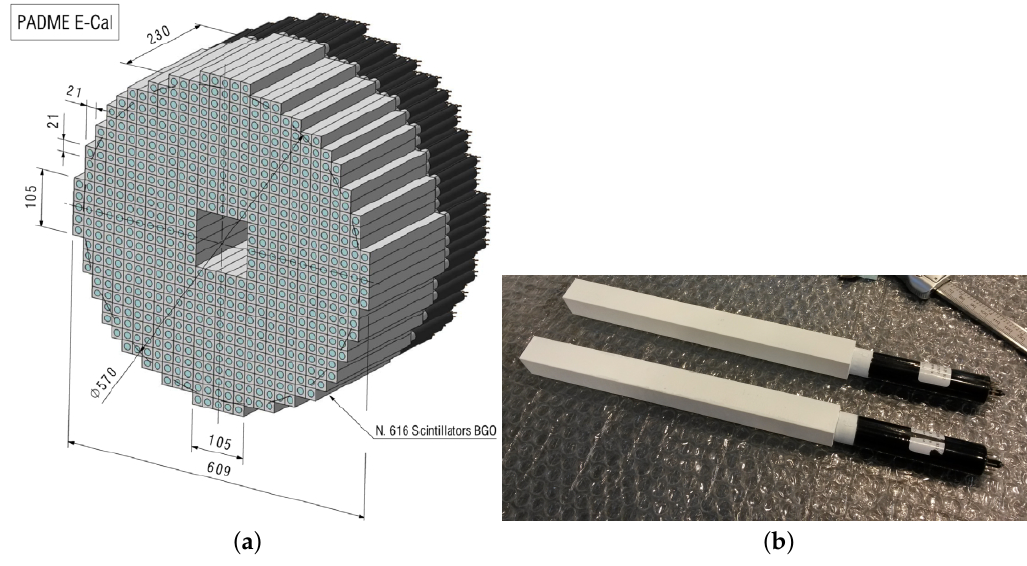
Figure 3. ( a ) ECAL design with dimensions in mm; ( b ) HZC XP1912 PMTs painted and glued to BGO crystals.